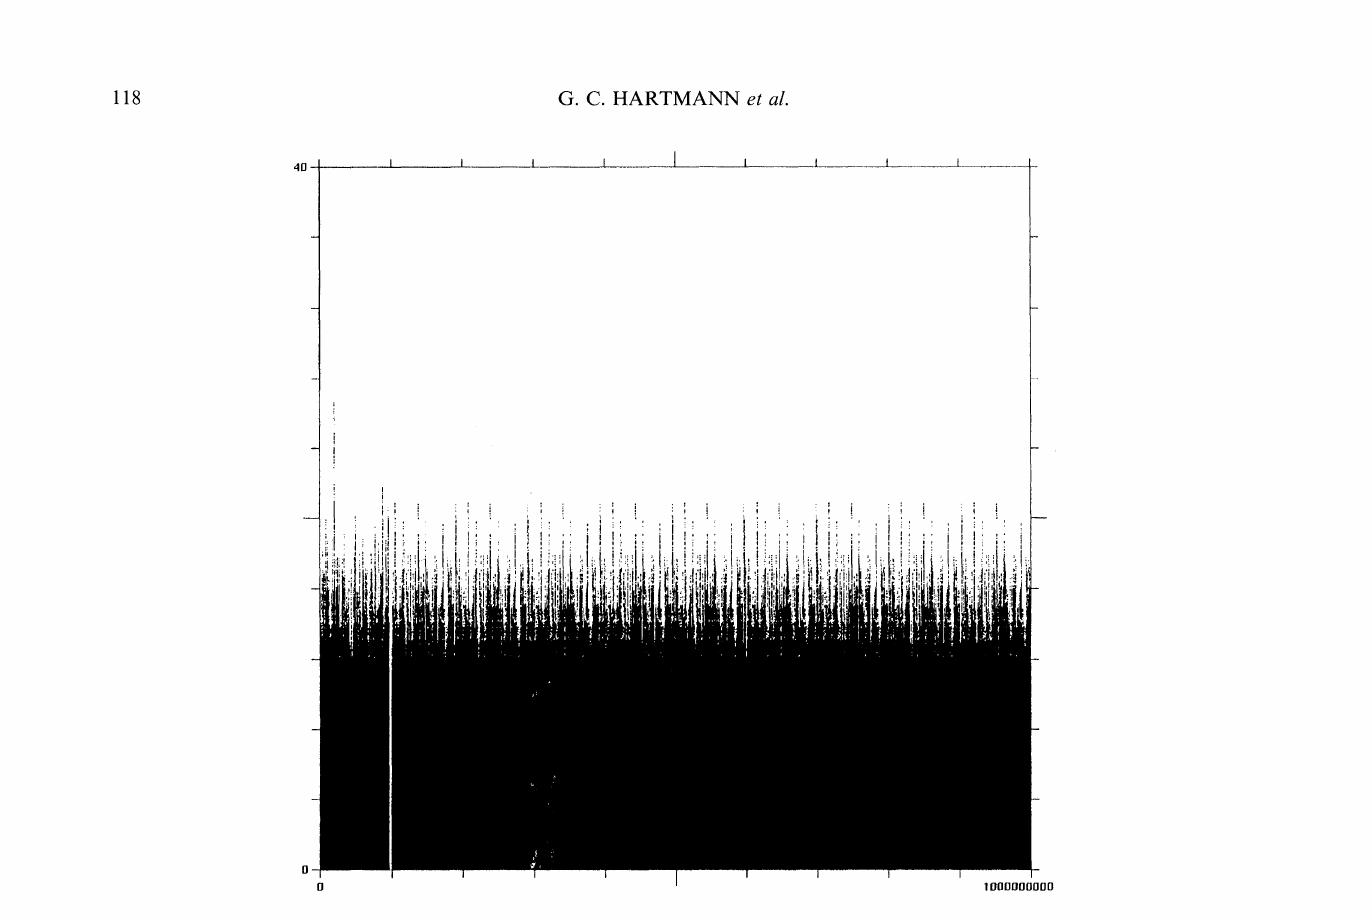
FIGURE 11 A hundred times longer calculation then in Figure 10, in two potions. The first portion occupies the first ten percent of the picture and contains 100 million timesteps, ten times more than Figure 10. The second, longer portion has the same resulation and hence is an hundred times longer version of Figure 10. One sees on closer inspection that a periodically recurring pattern has set in, with a period of about 100 million time steps. The series of pictures beginning with Figure 7 thus ends up in periodicy. The first portion here, in contrast, was calculated at 8192 binary digits accuracy (corresponding to 2600 decimal digits), using the algorhithm of Eq. (4). Note the single, much higher peak